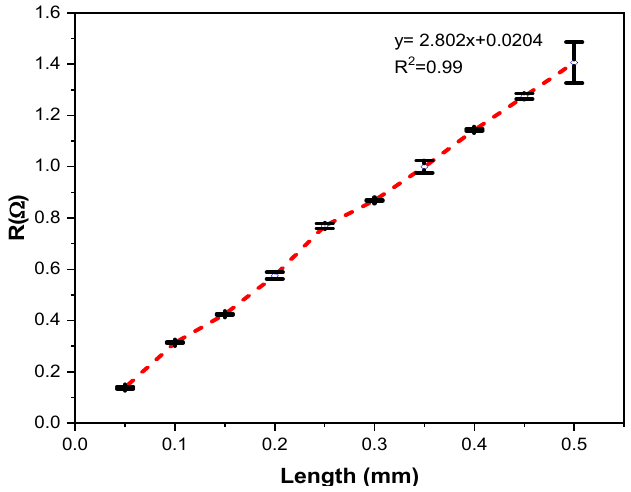
Figure 8. Effects of length on resistance of SCV conductive yarn.